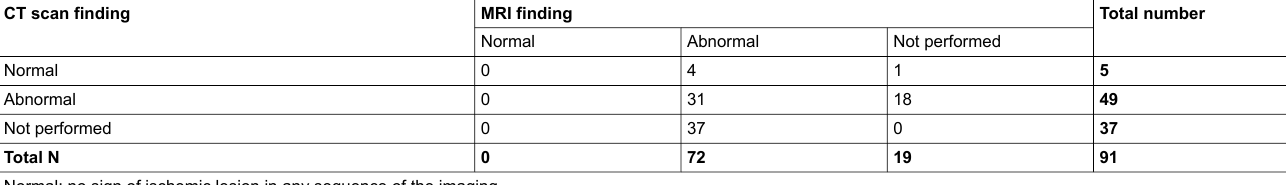
Table 3: Localisation of lesion in diagnostic imaging. Localisation